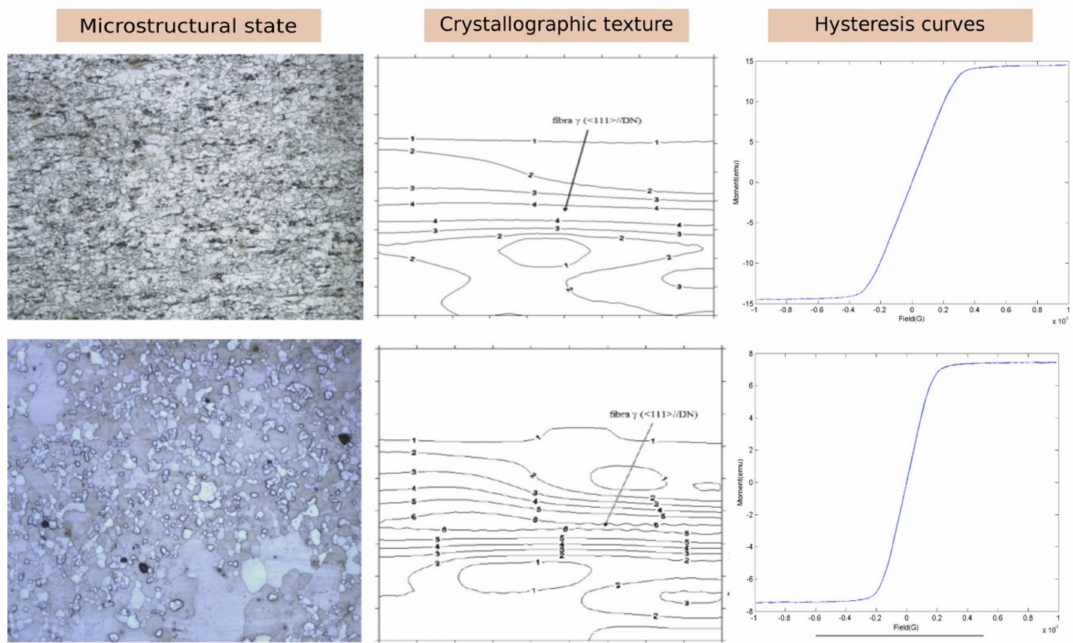
Figure 8. Conventional forms of characterization typically implemented in the manufacturing of electrical steels. Mi- crographs have been used to separate lower= and higher-efficiency materials [24]. This article is published under the terms of the Creative Commons Attribution-Non-Commercial-No Derivatives License (CC BY NC ND) (https: //creativecommons.org/licenses/by-nc-nd/4.0/ accessed on 12 March